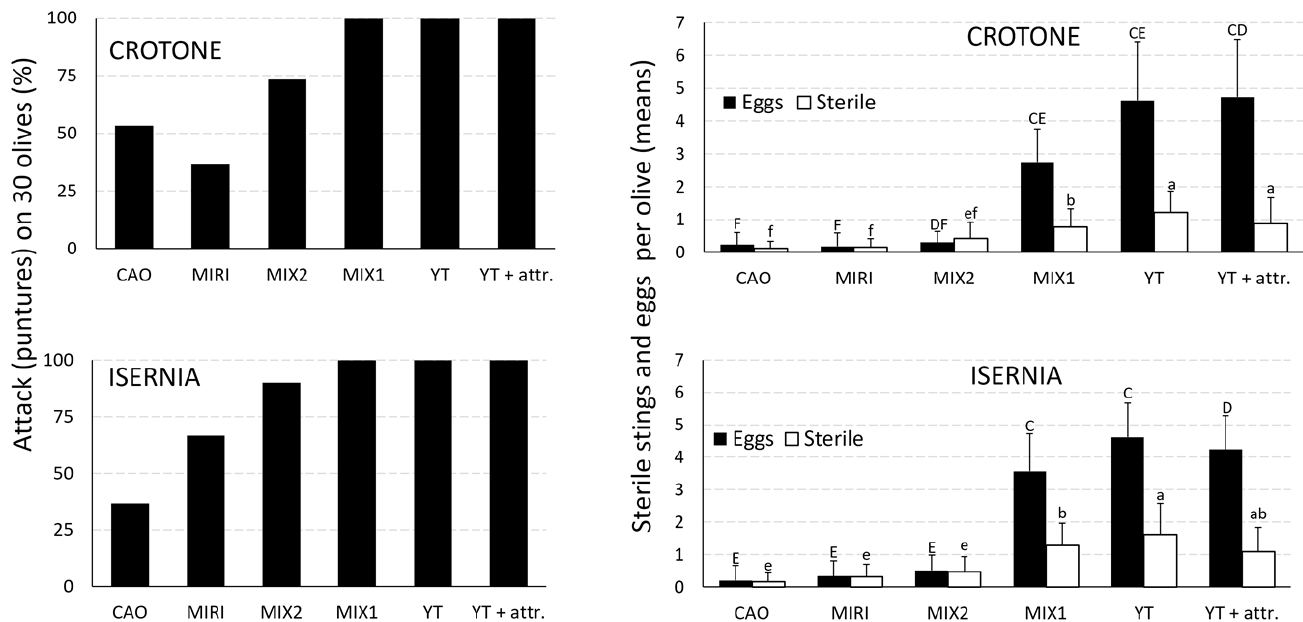
Figure 6. Mean number of stings with (black) and without (white) laid eggs of OLF recorded on the drupes at the harvest in the clusters of the field trials in Crotone (Calabria – Italy) (upper graphs) and in Pozzilli (Isernia, Molise – Italy) (lower graphs) and, left to each graph, percentage of oviposition stings on 30 random collected olives. Abbreviations as indicated in Figure 5. Different letters mean significance, one-way ANOVA test, Post-hoc Student – Newman – Keuls test. Uppercase and lowercase letters are exclusively referred to laid eggs and sterile stings respectively.